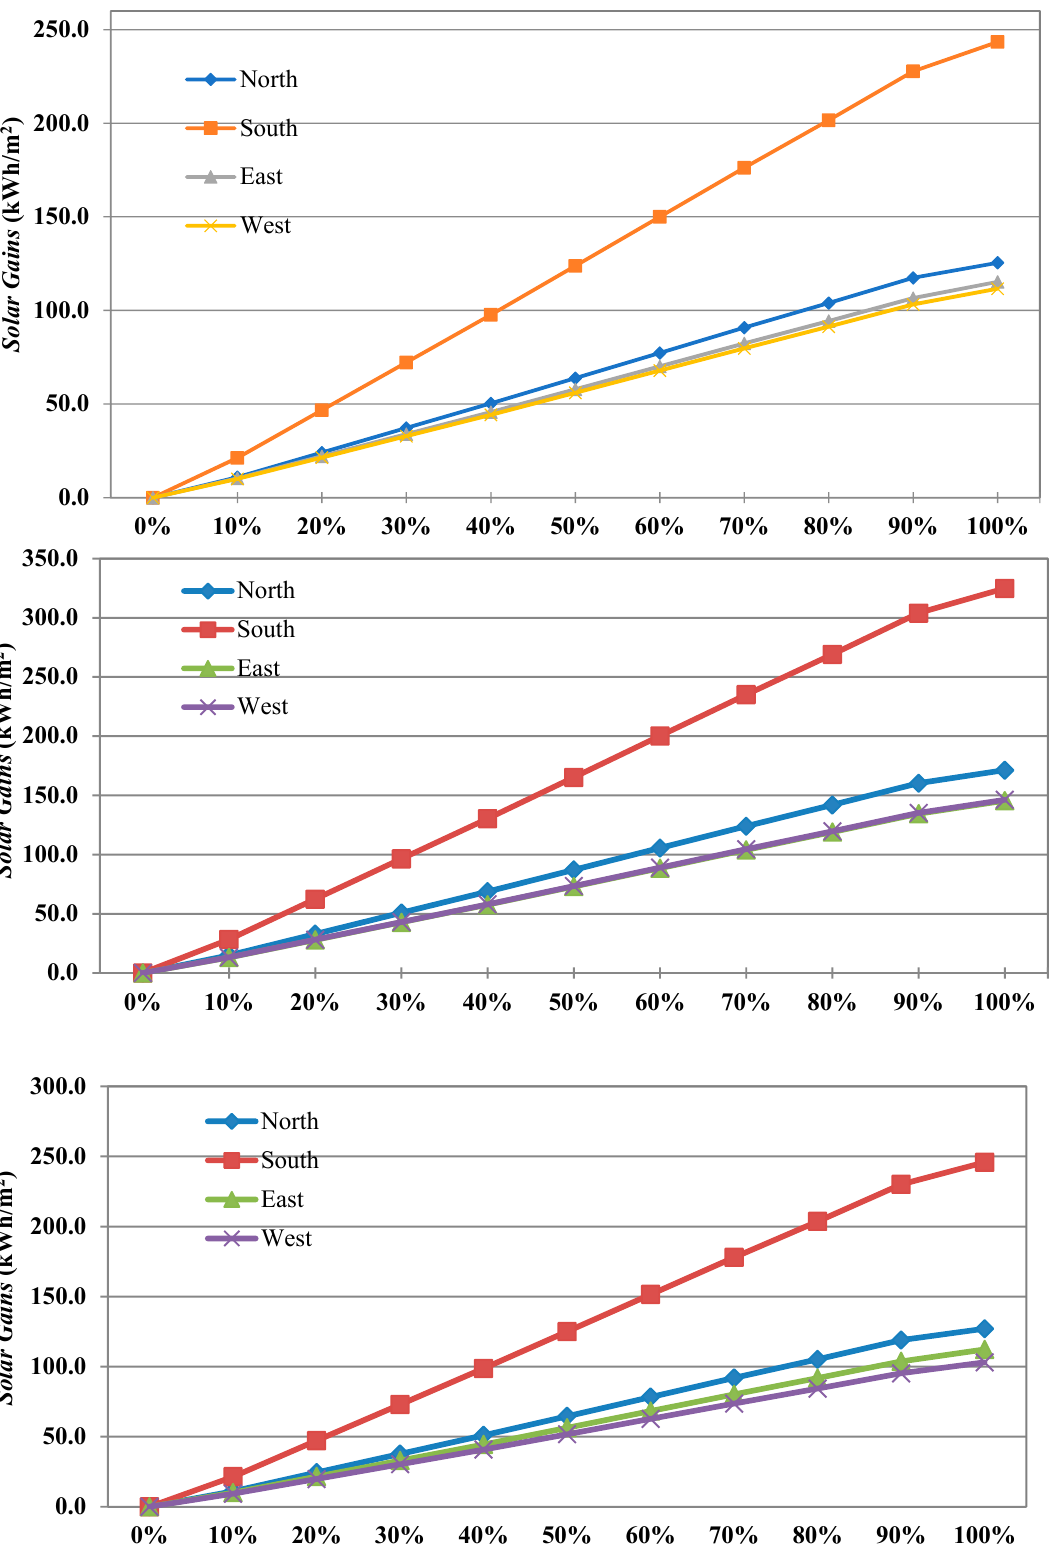
Figure 4. Annual solar heat gain of buildings with different percentages of windows at different facades for Bushehr (upper), Shiraz (middle), and Tabriz (below), Iran.